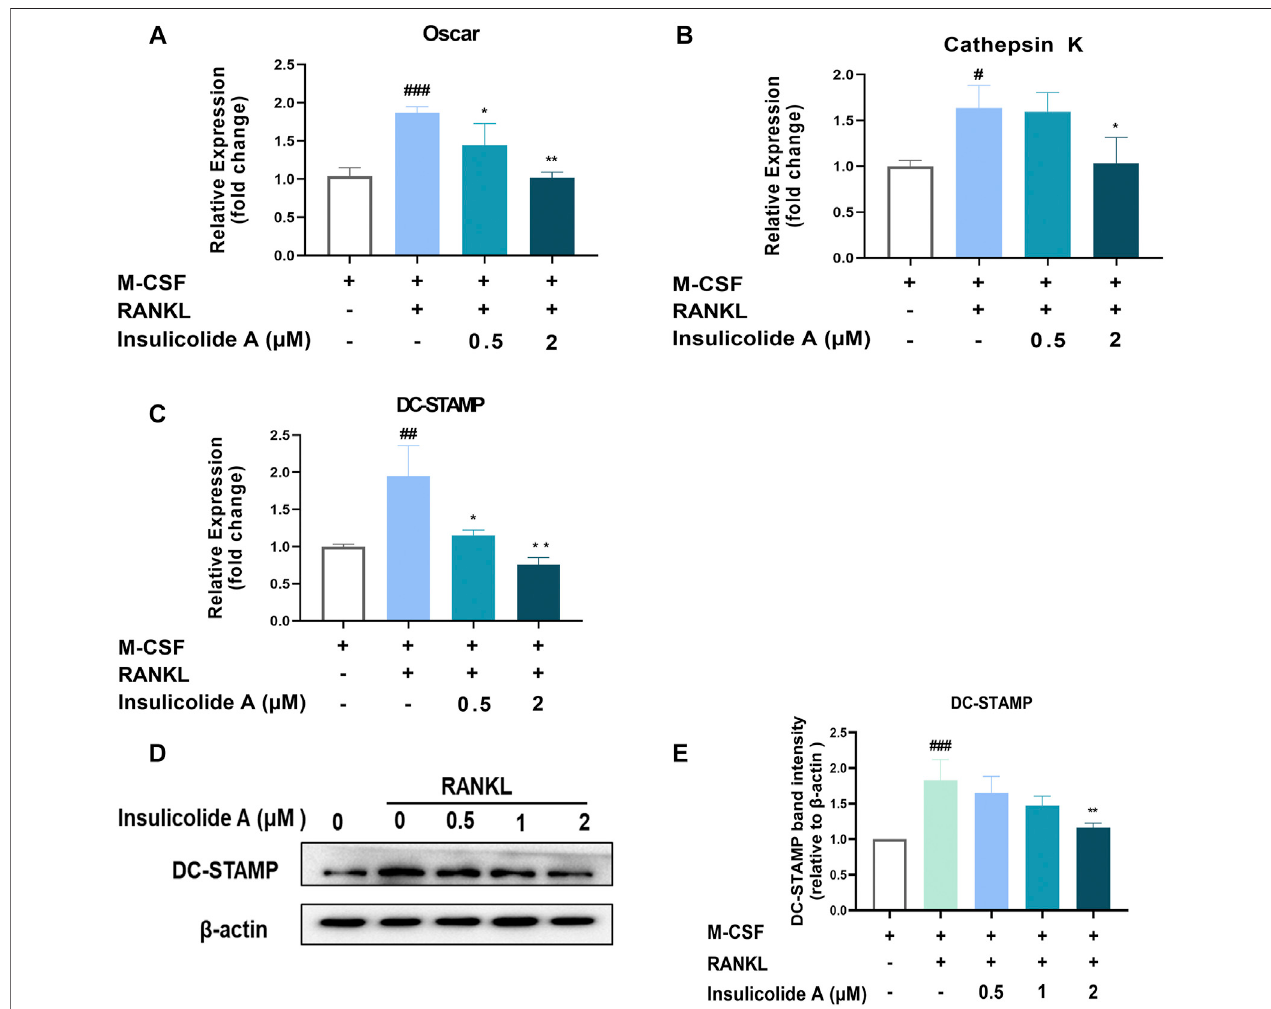
FIGURE 4 | Insulicolide A attenuated the expression of osteoclast-related genes and DC-STAMP induced by RANKL. Insulicolide A (0.5 – 2 μ M) in BMMs were fi rst culturedfor4 h,thenfollowedby100 ng/mlofRANKLstimulation for24 h.Afterthat,real-timePCRwasusedtoanalyzthegeneexpression ofOSCAR (A) ,cathepsinK (B) ,andDC-STAMP (C) .AntibodieswereusedtodetectthetotalproteinsexpressionofDC-STAMPand β -actin (D) . (E) TherelativeexpressionofDC-STAMPto β -actin was analyzed by ImageJ software. The data are shown as means ± SD of three independent experiments. # p < 0.05, ## p < 0.01, ### p < 0.001 vs. nontreatment groups, * p < 0.05, ** p < 0.01 vs. RANKL-induced groups.